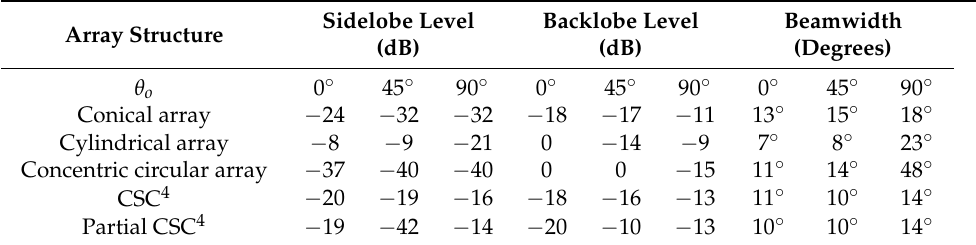
Table 4. Summary of array performance for different array structures and the proposed CSC 4 and partial CSC 4 .